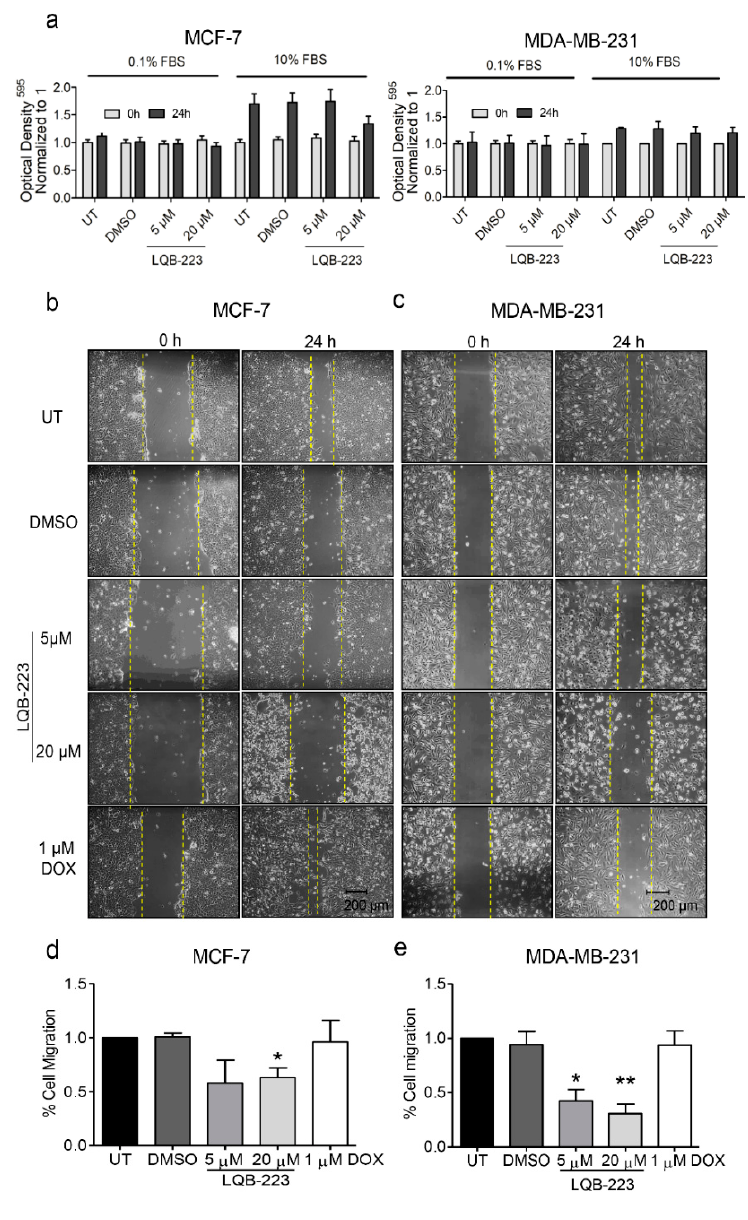
Figure 1. Assessment of proliferation in serum-deprived conditions and cell migration using the wound healing assay. ( a ) MCF-7 and MDA-MB-231 cells were cultured in DMEM containing 10% FBS or 0.1% FBS and treated with LQB-223 at the indicated concentrations for 24 h. Absorbance of cells stained with crystal violet was measured at 595 nm. ( b ) MCF-7 and ( c ) MDA-MB-231 cells were cultured in DMEM 0.1% FBS and treated with 5 or 20 µ M of LQB-223 for 24 h. Wound closure was monitored and calculated using the software ImageJ. Yellow dotted line shows the gap area detected using ImageJ. Migration quantification of ( d ) MCF-7 and ( e ) MDA-MB-231 in percentage of covered area compared to the same region at 0 h timepoint. Values reported as mean and standard deviation of three independent experiments. Statistical significance was analyzed using the student’s t test (* p < 0.05; ** p < 0.01). UT: Untreated cells; DMSO: Dimethyl sulfoxide; DOX: Doxorubicin.